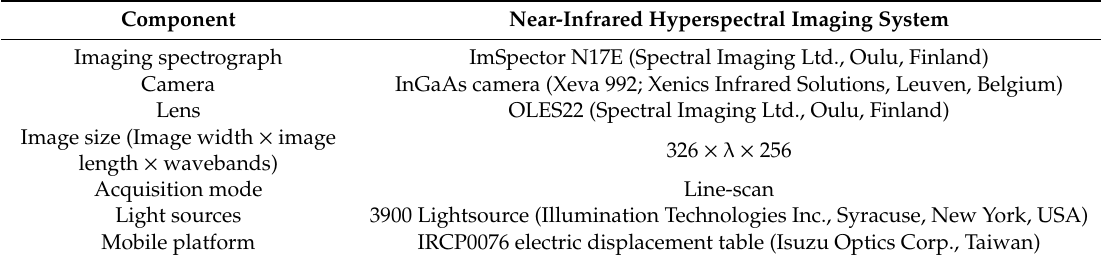
Table 1. Main components of the near-infrared hyperspectral imaging